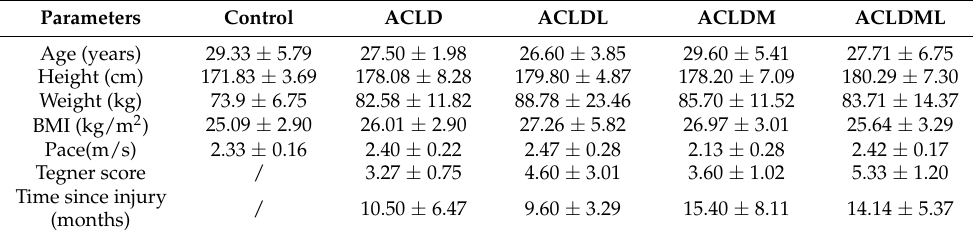
Table 1. Participant characteristics in each group *.